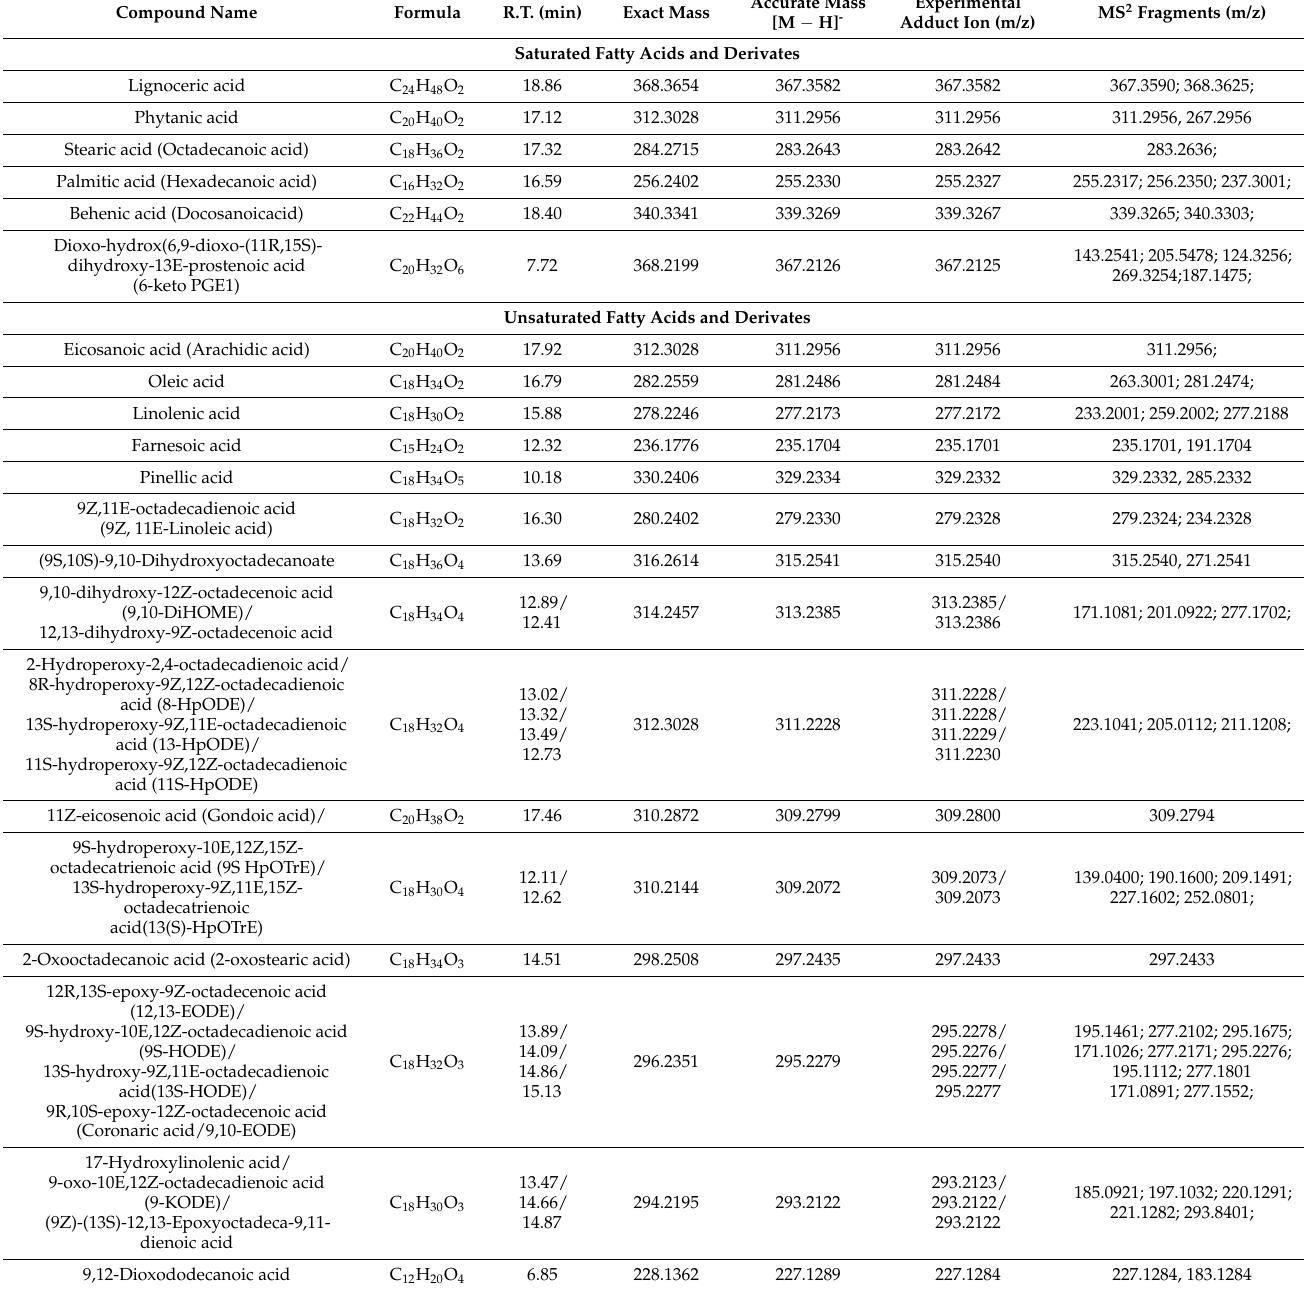
Table 4. Identification of fatty acids and some derivatives in chestnut extract by UHPLC-Q-Exactive high-accuracy analysis of deprotonated precursors and fragment ions of specific components com- bined with data processing using Compound Discoverer